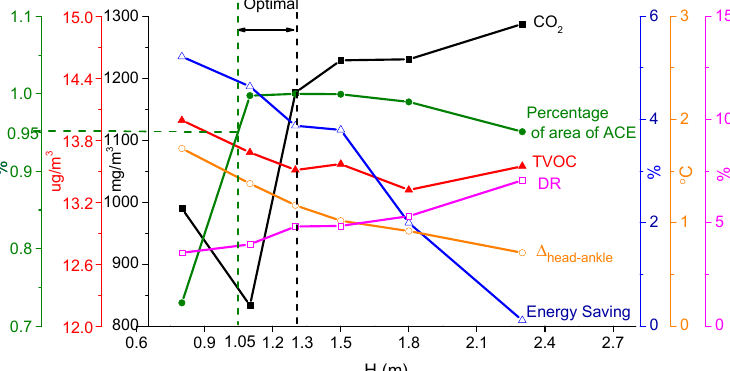
Figure 1. Comprehensive indices at different height of return air vent in cooling mode.